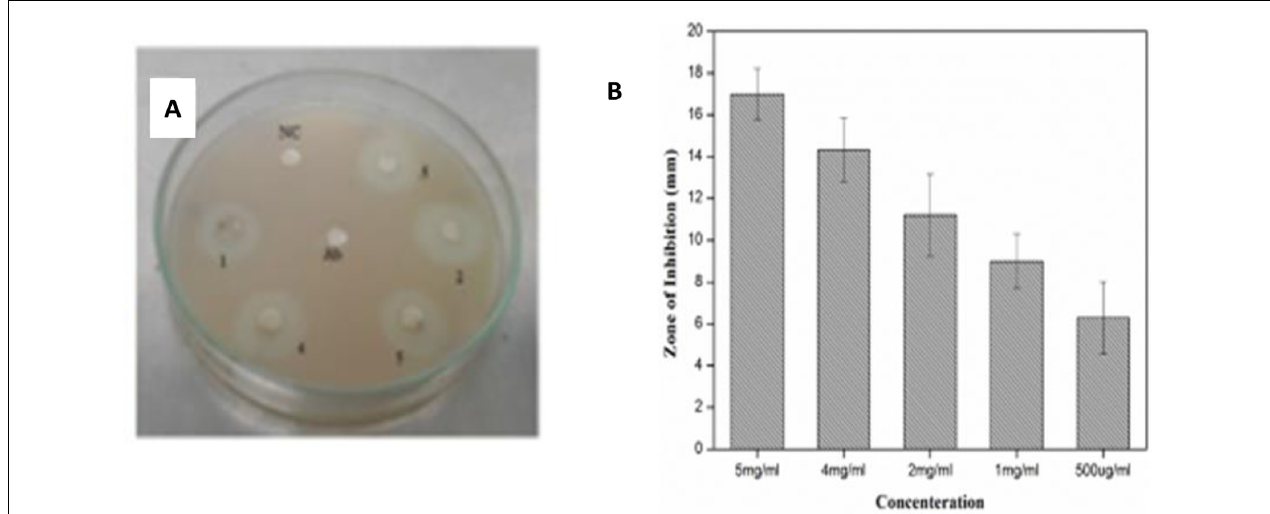
FIGURE 7 | (A) Assay of protein Kinase Inhibition by ZnO-NPs. (B) Quantified protein kinase inhibition (in mm) by ZnO-NPs.